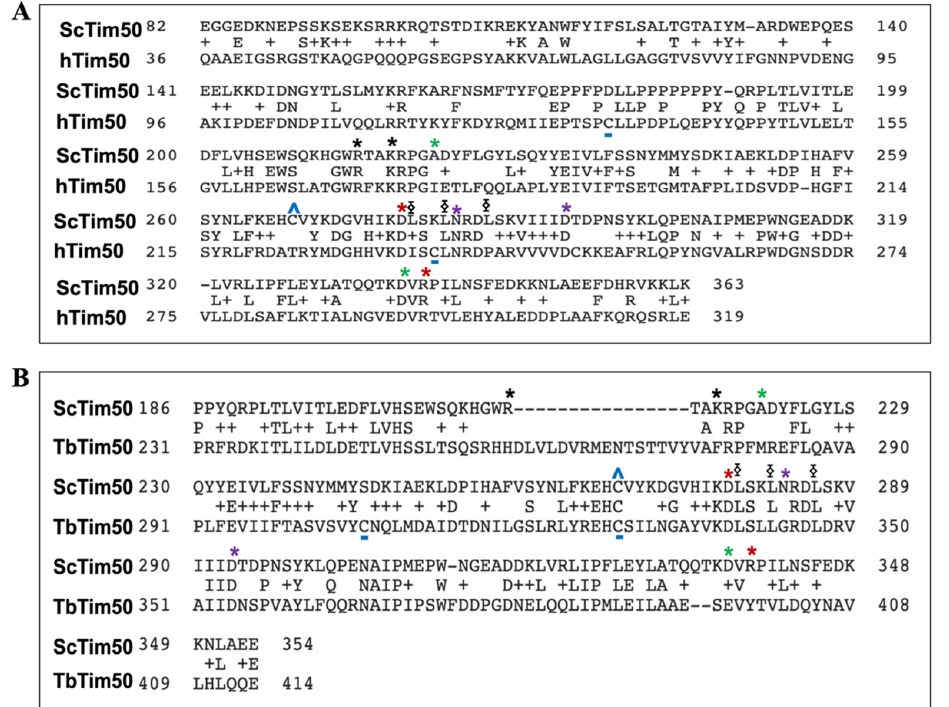
Figure 5. Primary sequence alignment of ScTim50 with hTim50 ( A ) and TbTim50 ( B ). Relatively conserved regions are shown. Identical AA residues are indicated. The conserved and non-conserved cysteine residues are indicated by blue ^ and underscore, respectively. Leucine residues within the conserved coiled-coil region (L279, L282, and L286 in ScTim50) are marked by ⧮ . AA residues R214 and K217 located on the lateral side of the β-hairpin loop that are responsible for interaction with Tim23 are indicated by *. Three AA pairs that are important for the interaction between ScTim50 and ScTim23 are shown by asterisks of different colors (*, *, and *).